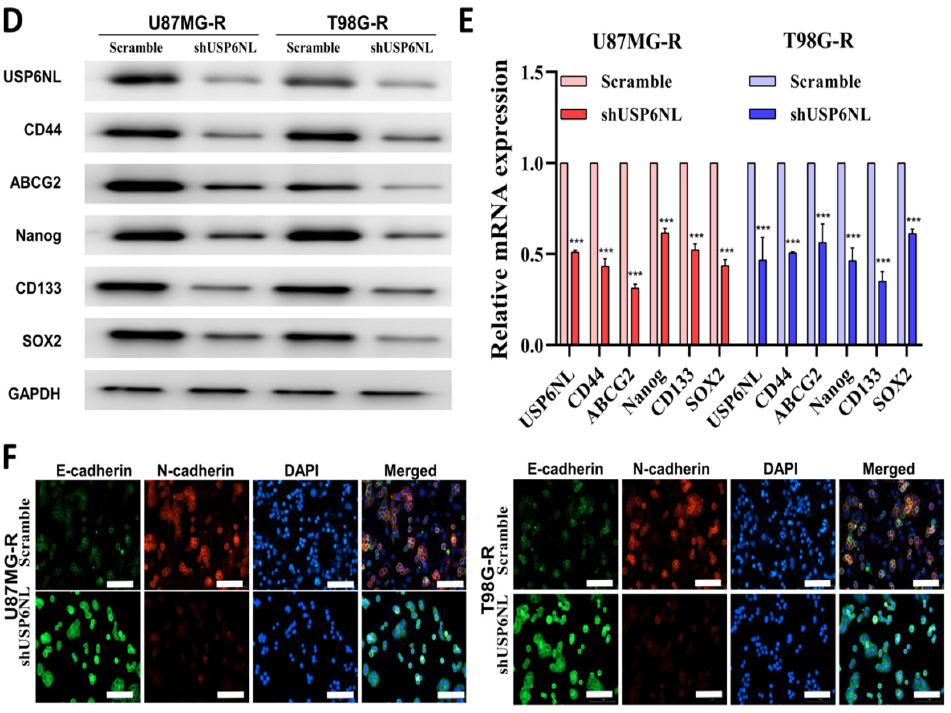
Figure 4. USP6NL inhibition regulates cancer stemness properties of GBM cells. ( A – C ) Representa- tive image of colony-forming (self-renewal ability), tumor initiation (sphere assay), and migra- tory/invasive properties of USP6NL-knockdown GBM cells (U87MG-R and T98G-R). Scale bar: 100 µ m. ( D , E ) Western blot and qRT-PCR results of the expression of key CSC’s markers associated with therapy resistance. ( F ) The EMT process in USP6NL-knockdown GBM (U87MG-R and T98G-R) cells was also examined through IF analysis of E-cadherin and N-cadherin staining. Scale bar: 10 µ m. *** p < 0.001.